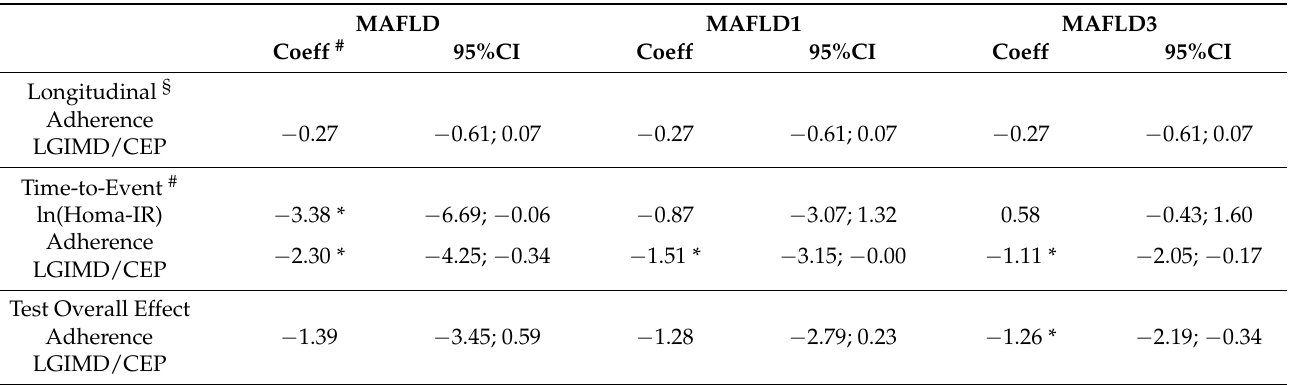
Table 4. Joint modeling of longitudinal trajectory (HOMA-IR) and Time-to-Event (Loss of MAFLD diagnostic criteria): Effect of Adherence to LGIMD and